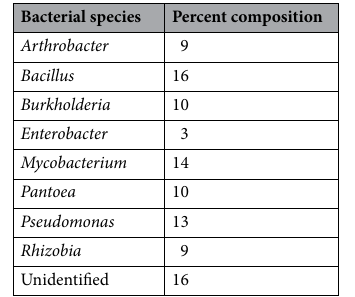
Table 1. Percent bacterial composition of PSB